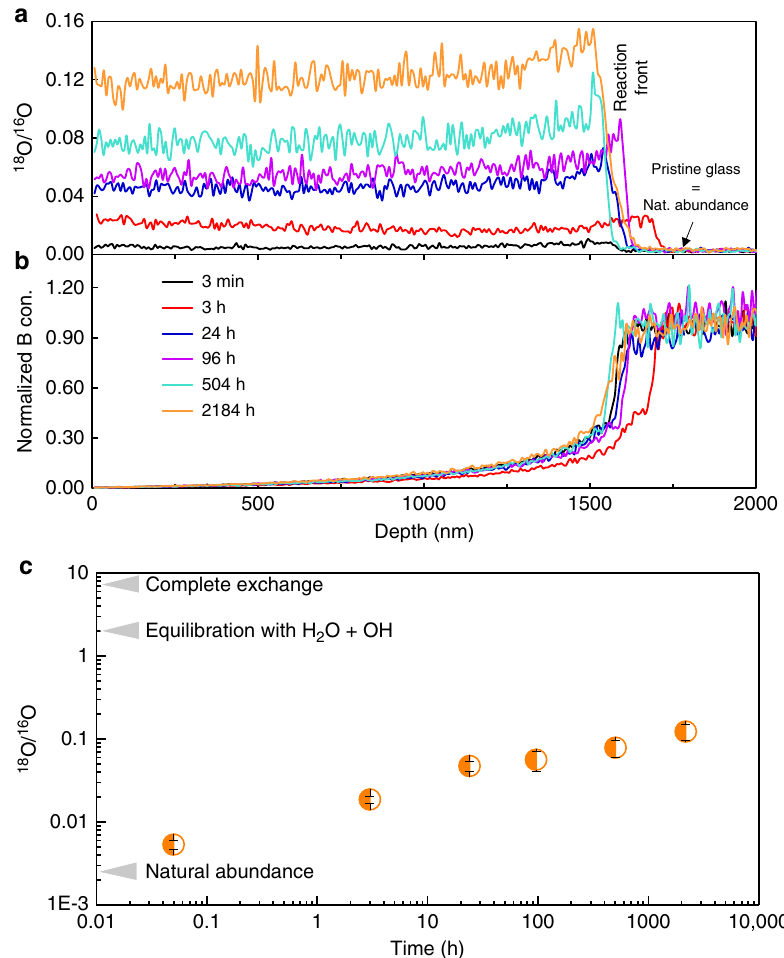
Fig. 2 Water mobility in the gel. Water mobility is recorded by time-dependent isotopic and elemental ToF-SIMS pro fi les (experiment 1). For a and b , only lines are displayed for a better readability, and the analytical step is 7 nm. a Quantitative 18 O/ 16 O pro fi les in the gel for the different contacting durations. The mean value of the O isotopic ratio in the pristine glass (2.2 × 10 − 3 ) is within uncertainty of the natural abundance (2.05 × 10 − 3 ). b Normalized boron pro fi les for the same durations. The alteration front, given by the normalized concentration of 0.5 is located at 1574 ± 20 nm. The shifts between the different pro fi les give the analytical error of the technique, which is small. For a given contacting time, the B pro fi le is well anti-correlated with the 18 O/ 16 O pro fi le, indicating that some tagged water molecules reached the glass dissolution front at all tested durations. Some B is retained in the gel as evidenced by the B concentration on the gel side of the gel/pristine glass interface, which does not fall to zero. This likely corresponds to undissolved glass clusters 15 . c Evolution of the mean value of the oxygen isotopic ratio within the gel as a function of contacting time with the H 2 18 O solution. Error bars are calculated from uncertainites on natural abundance in the pristine